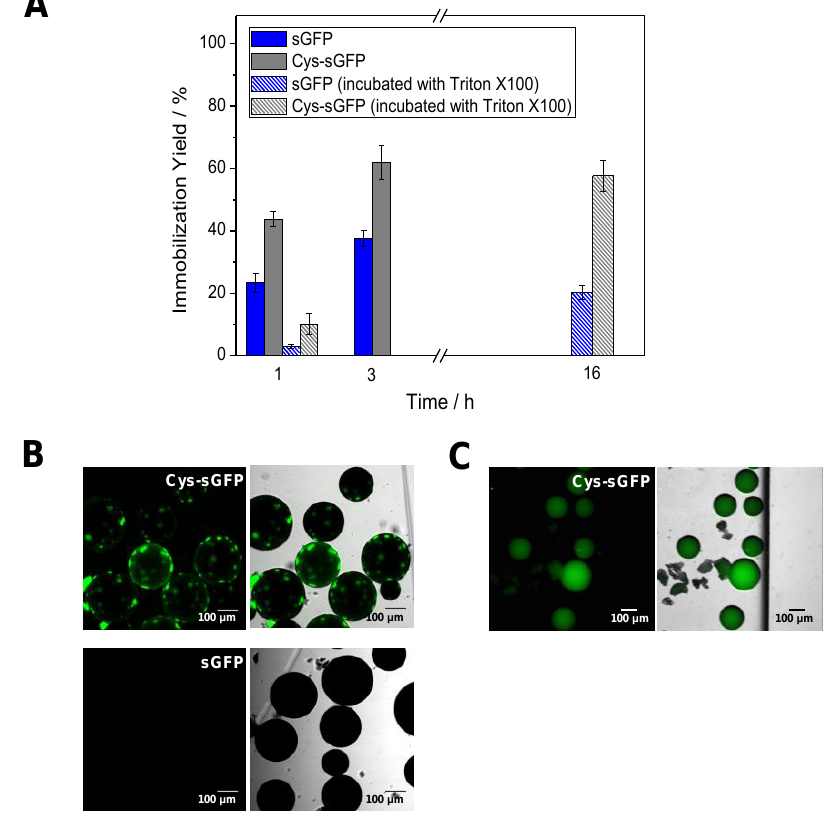
Figure 3. Immobilization of Cys-sGFP on Purolite ® . ( A ) Immobilization course of sGFP and Cys-sGFP on the epoxy-activated carrier. The yields were calculated by measuring the fluorescence of the supernatants after immobilization (Section 3.5). ( B ) CLSM imaging of the biomaterial after washing steps with Triton X-100. ( C ) CLSM imaging of the biomaterial as a result of incubation with Triton X-100 during the protein immobilization step. Left columns, images of fluorescence ( λ ex : 488 nm, λ em : LP505 nm); right columns, overlay of fluorescence and brightfield signals. The protein immobilization scheme is the same as the one depicted in Figure 1A.